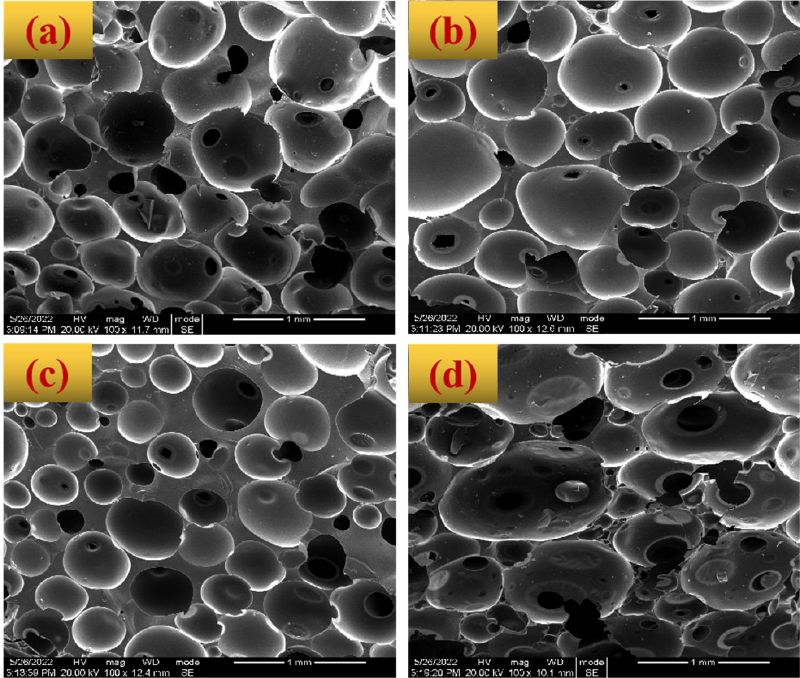
Figure 5. SEM images of BZPN foams formed at various foaming temperature: ( a ) 120 °C, ( b ) 140 °C, ( c ) 160 °C, and ( d ) 180 °C.